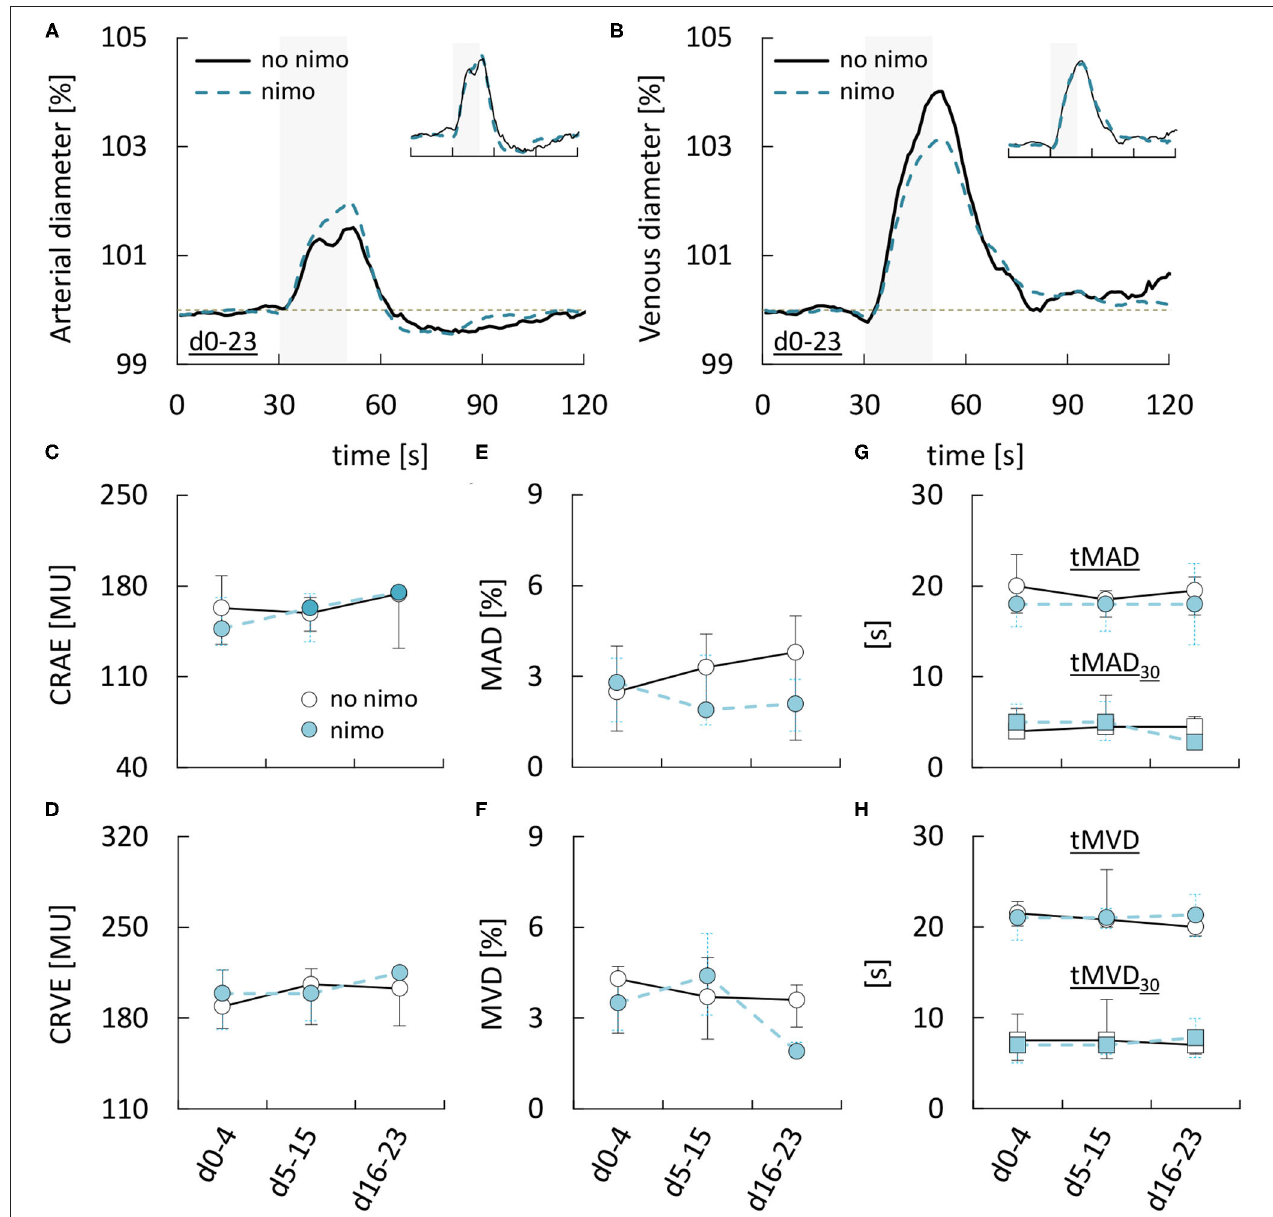
FIGURE 5 | Dependence of retinal vessel properties in aSAH patients on nimodipine treatment. (A) Average relative arterial responses to flicker light stimulation measured with or without nimodipine (nimo) treatment. Inset shows the same data but scaled to the same amplitude for comparison of response kinetics. Stimulation period is indicated by light gray shading. (B) Average relative venous responses to flicker light stimulation measured with or without nimodipine (nimo) treatment. Inset shows the same data but scaled to the same amplitude for comparison of response kinetics. Stimulation period is indicated by light gray shading. (C–H) Comparison of (C) central retinal arterial equivalent (CRAE), (D) central retinal venous equivalent (CRVE), (E) maximum arterial dilation (MAD), (F) maximum venous dilation (MVD), (G) time to 30 and 100% of maximum arterial dilation (tMAD 30 & tMAD), and (H) time to 30 and 100% of maximum venous dilation (tMVD 30 & tMVD) in aSAH patients with or without nimodipine treatment during the early (aSAH d0 − 4 ), critical (aSAH d5 − 15 ), and late (aSAH d16 − 23 ) phase.